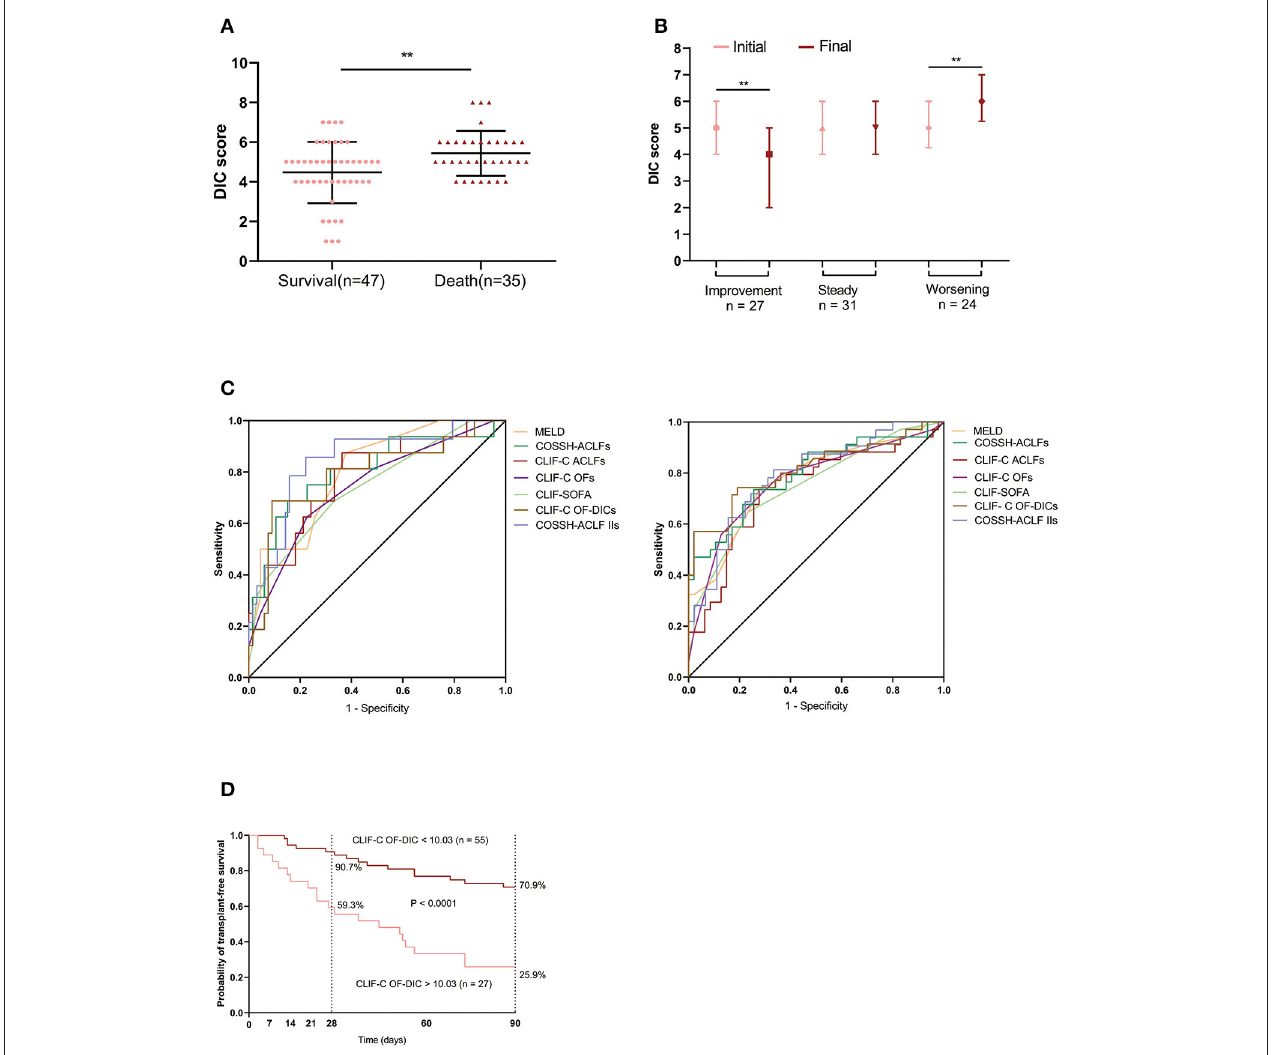
FIGURE 5 | DIC scores in external HBV-ACLF validation cohort. (A) The bars indicate DIC scores between patients who survived or died within 90 days. (B) Changes in DIC scores from initial to final assessments according to clinical course. Initial: the DIC score was assessed at baseline; final: the last DIC score assessed within 28 days of diagnosis, or before death or discharge from the hospital. (C) Comparison of CLIF-C OF-DICs with MELD, COSSH-ACLFs, CLIF-C ACLFs, CLIF-C OFs, CLIF-SOFA and COSSH-ACLF-IIs in predicting 28-day and 90-day mortality of ACLF patients. The areas under the receiver operating curve were as follows. For 28-day mortality: CLI-C OF-DICs, 0.791; CLIF C-OFs, 0.744; CLIF-C ACLFs, 0.784; CLIF-SOFA, 0.744; MELD, 0.804; COSSH-ACLFs, 0.804; COSSH-ACLF-IIs, 0.845. For 90-day mortality: CLI-C OF-DICs: 0.812; CLIF C-OFs, 0.767; CLIF-C ACLFs, 0.737; CLIF-SOFA, 0.741; MELD, 0.774; COSSH-ACLFs, 0.797; COSSH-ACLF-IIs, 0.790. (D) Probability of 28- and 90-day transplant-free survival in ACLF patients based on the CLIF-C OF-DICs cutoff value (10.03) acquired in the derivation cohort. DIC, disseminated intravascular coagulation; ACLF, acute-on-chronic liver failure; HBV-ACLF, hepatitis B virus-related ACLF; CLIF, Chronic Liver Failure; CLIF-SOFA, CLIF-sequential organ failure assessment score; CLIF-C OF-DICs, a novel prognostic score based on age, DIC score, and CLIF-C OFs; MELD, Model for end-stage liver disease; CLIF-C ACLFs, CLIF-Consortium ACLF score; CLIF-C OFs, CLIF-Consortium Organ Failure score; COSSH-ACLFs, Chinese Group on the Study of Severe Hepatitis B-ACLF score; COSSH-ACLF IIs, Chinese Group on the Study of Severe Hepatitis B-acute-on-chronic liver failure II score. * P < 0.05, ** P < 0.01, and *** P <